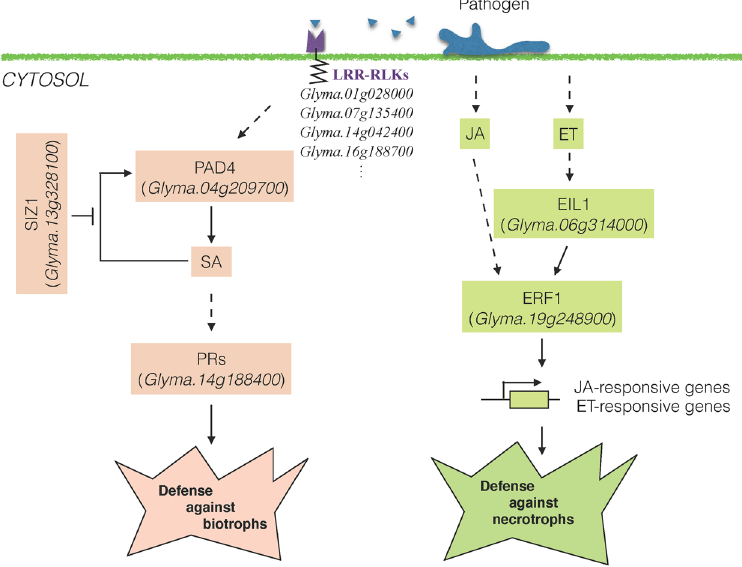
Figure 4. Proposed phytohormones-dependent disease defense model against Sclerotinia sclerotiorum in soybean. SA, salicylic acid; JA, jasmonic acid; ET, ethylene; LRR-RLKs, Leucine-rich repeat receptor-like protein kinases; PAD4, Phytoalexin-dependent4; SIZ1, small ubiquitin-related modifier E3 ligase; PRs, Pathogenesis- related proteins; EIL1, Ethylene-insensitive 3-like 1; ERF1, Ethylene response factor